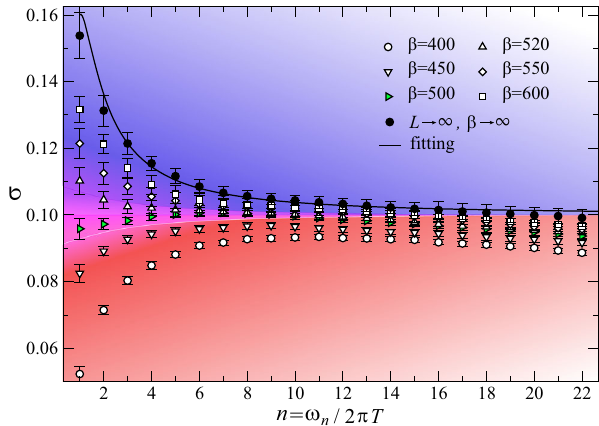
Fig. 3 Topological signatures at 1/3 fi lling. The conductivity data of our kagome lattice model at boson fi lling 〈 n i 〉 = 1/3 as a function of n = ω n / 2 π T at the XY * critical point ( t / V ) c = 0.07773(5), with V 0 = V ¼ 0 : 005, L = 12, 24, 36, 48, 60, 72 and β V = 400, 450, 500, 520, 550, 600. In the thermodynamic limit L → ∞ and then β → ∞ , the universal constant σ ð1Þ appears, and we obtain σ ð1Þ ¼ 1 σ ð1Þ as discussed in the XY (cid:3) XY (cid:3) XY 4 text. As in Fig. 2, we see a thermal crossover from a particle-like conductivity (blue) to a vortex-like one (red). The self-dual regime occurs around β * ≈ 500 (c.f. the green